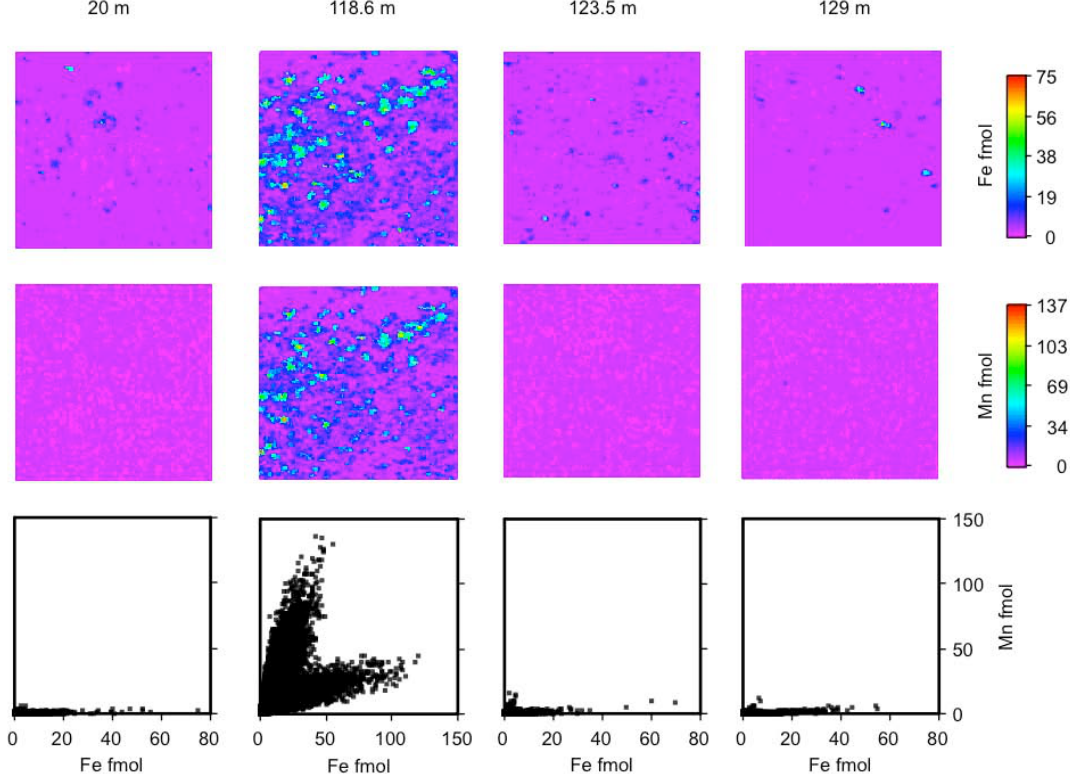
Fig. 6. Two-dimensional contour maps (1mm 2 ) acquired by synchrotron-based µXRF showing Mn and Fe associations. The bottom row of graphs show scatter plots of fmol Fe versus fmol Mn from the µXRF maps. Oxides are formed near 118.6m, and two distinct populations are visible there. There is a background population of high Fe-low Mn particles visible at all other